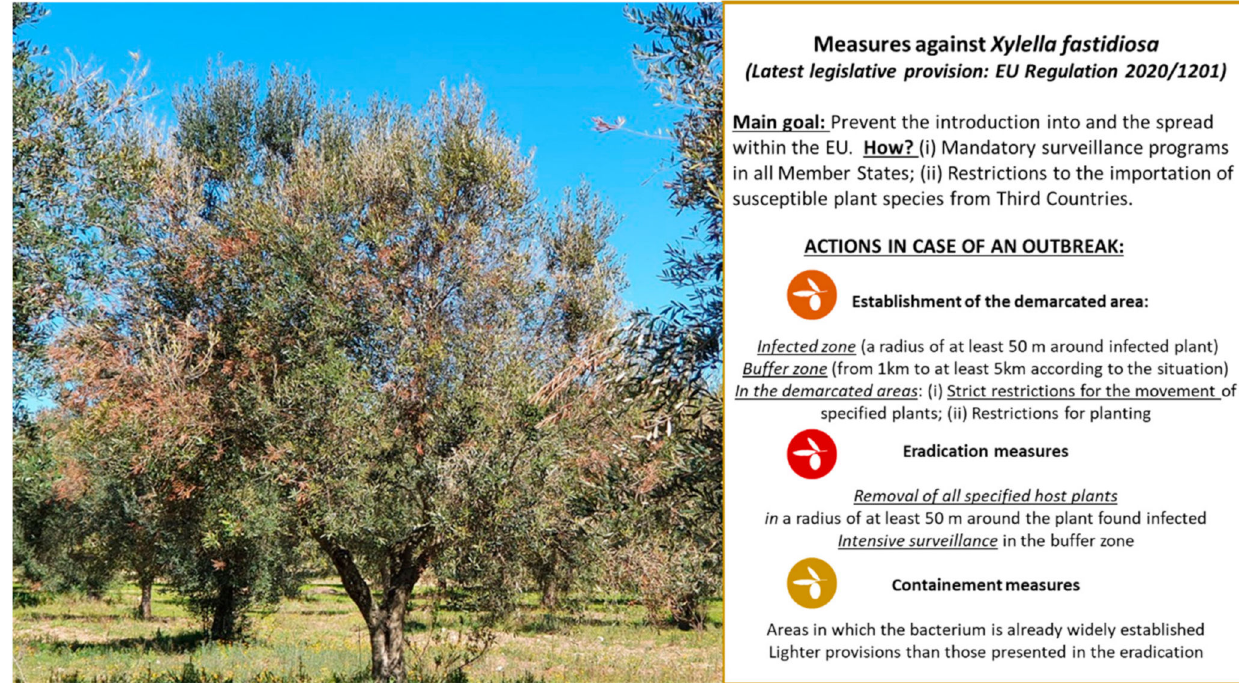
Figure 1. Measures of containment/eradication against Xylella fastidiosa